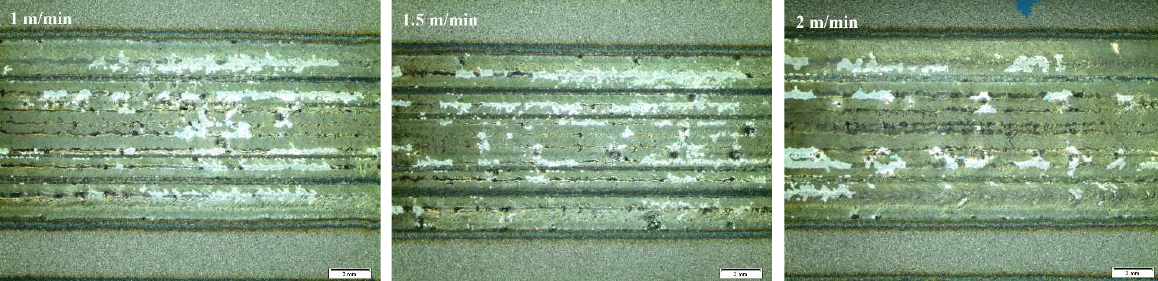
Figure 6. Morphology of the laser-alloyed tracks of surface of SSSs for sample 3.